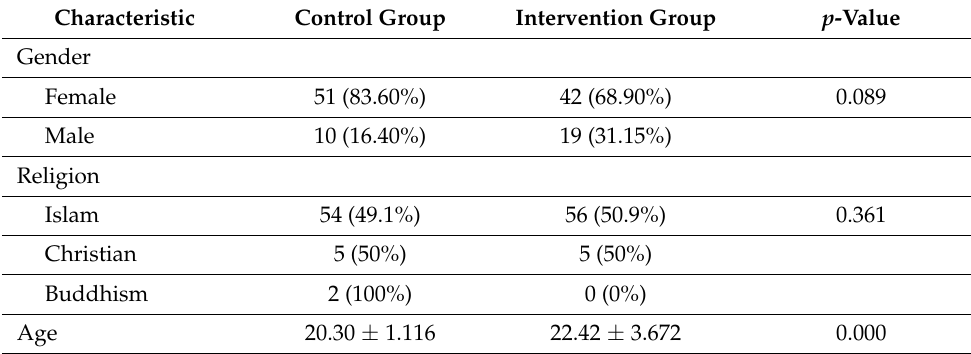
Table 1. Demographic of participants.